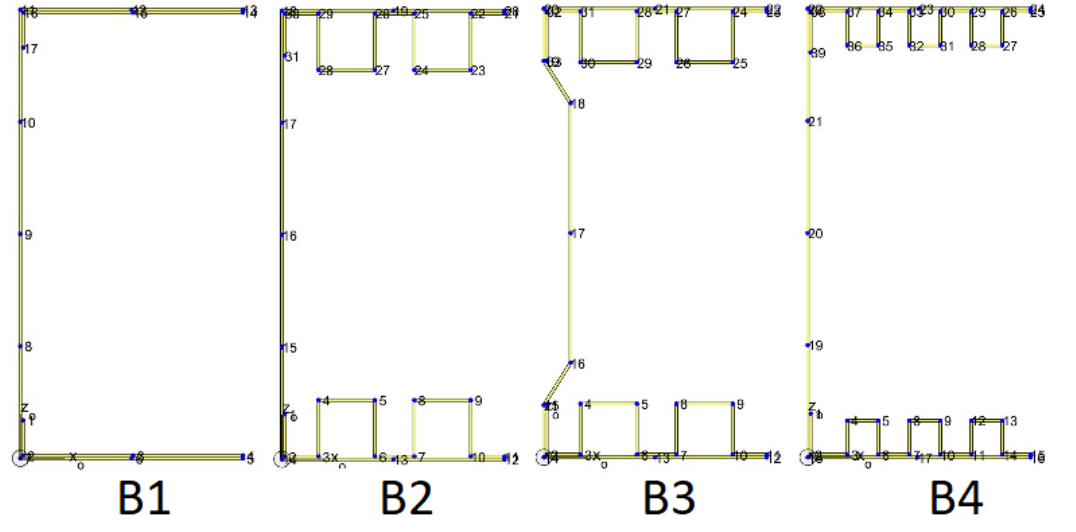
Figure 11. Division of the analysed cross-sections into strips. Column B1 was divided into 16 strips, column B2 into 30 strips, column B3 into 32 strips. Column B4 has 38 strips. The stripes are of different lengths. In the case of modified flange shapes, the length of each flange is equal to the length of the box sides. However, the outer sheet on the flanges is divided into two strips, and the sheet on the webs into four strips, except for column B8, which has a non-standard web shape. For column B3, the web is divided into six strips. For column B2, a check was made on the influence of the number of finite stripes on the results obtained. The analysis has shown that the optimum number of stripes on the web is four, and on the flanges two. The results of the analysis are presented in Table 7. Table 7. Analysis of the influence of the number of stripes on the flanges and on the web of the numerical analysis results of CuFSM.